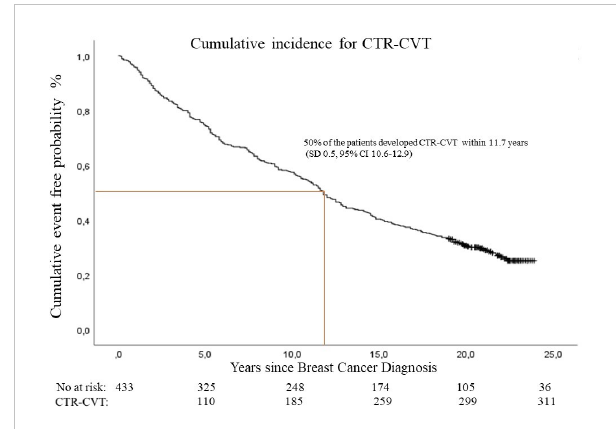
FIGURE 2 Cumulative incidence of cancer therapy-related cardiovascular toxicity (CTR-CVT) after breast cancer by years since diagnosis. 910 cancer therapy-related cardiovascular disease events in 311 patients with lymph node-positive early breast cancer at diagnosis in the Southeast Healthcare Region, Sweden, January 1, 1998, to December 31, 2002.